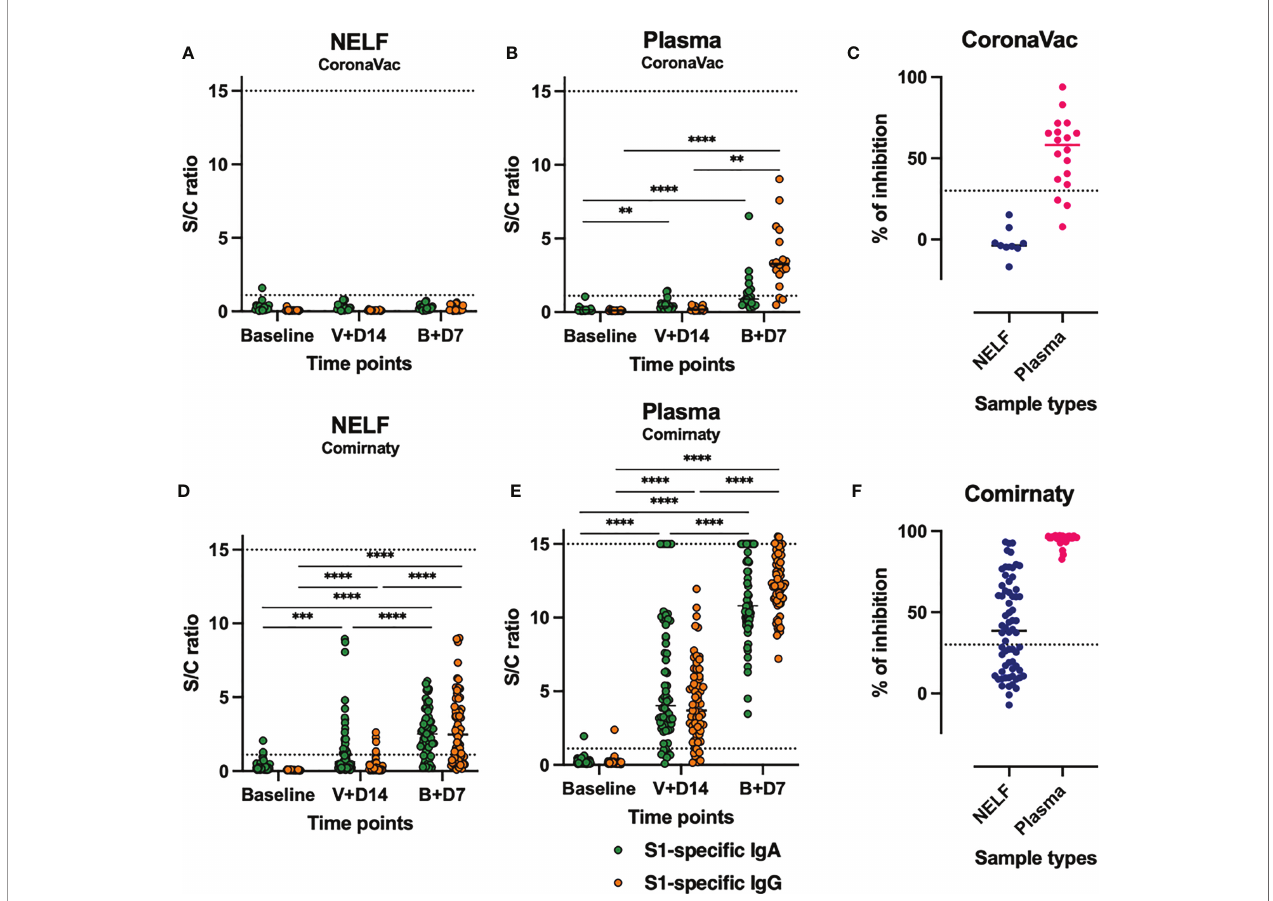
FIGURE 2 | Expression of nasal epithelial lining fl uid (NELF) and plasma S1-speci fi c IgA and IgG and neutralizing antibody (NAb). The level of S1-speci fi c IgA (green dots) and IgG (red dots) were plotted against the three standard time points of sample collection in NELF (A, D) and plasma (B, E) specimens of the recipients of CoronaVac (A, B) and Comirnaty (D, E) . The data points above the dotted line (sample/calibrator ratio ≥ 1.1) are considered positive, while the dotted lines at y = 15 indicate the upper detection limit of the assay. The asterisks indicate statistical signi fi cance between time points of the same Ig class by Friedman test, followed by Dunn ’ s multiple-comparison test. ** p < 0.001, *** p < 0.0005, and **** p < 0.0001. The percentage of signal inhibition observed with the surrogate SARS-Co-V 2 neutralization antibody detection kit by the NELF and plasma samples of CoronaVac (C) and Comirnaty (F) recipients collected on 7 ± 2 days after the booster is plotted. The 30% signal inhibition cutoff for SARS-CoV-2 NAb detection is interpreted as the sample containing neutralizing antibodies for